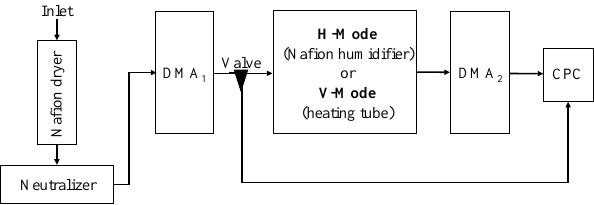
Figure 1. A schematic diagram of the hygroscopic and volatile tan- dem differential mobility analyzer